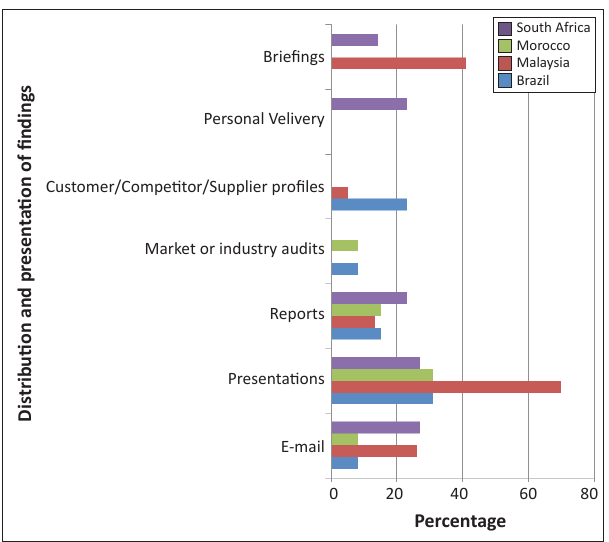
FIGURE 4: The five methods most used to distribute and present competitive intelligence